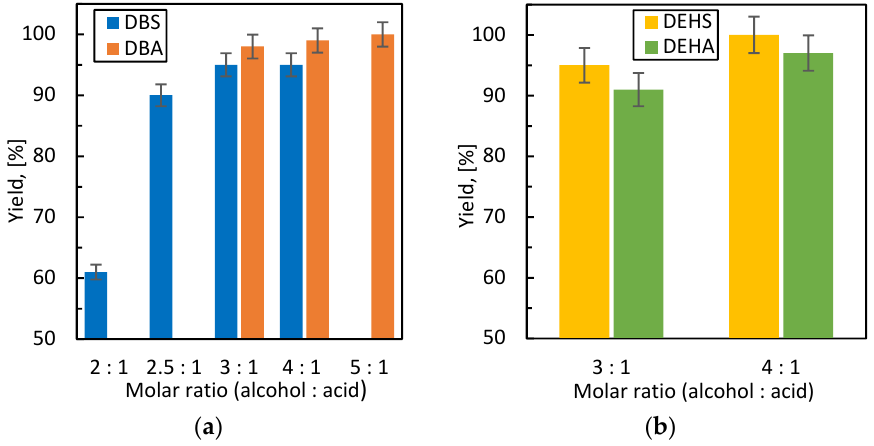
Figure 3. The influence of the amount of alcohol on the on the esterification of succinic and adipic acid with ( a ) butan-1-ol and ( b ) 2-ethylhexan-1-ol. Reaction conditions: acid 1 mol; IL 2.7 (15 mol%/mol succinic acid (0.0025 mol)); 60 °C (DBS, DEHS); 80 °C (DBA, DEHA); 17 Hz; reaction time for ( a ) 240 min, for ( b ) 120 min.